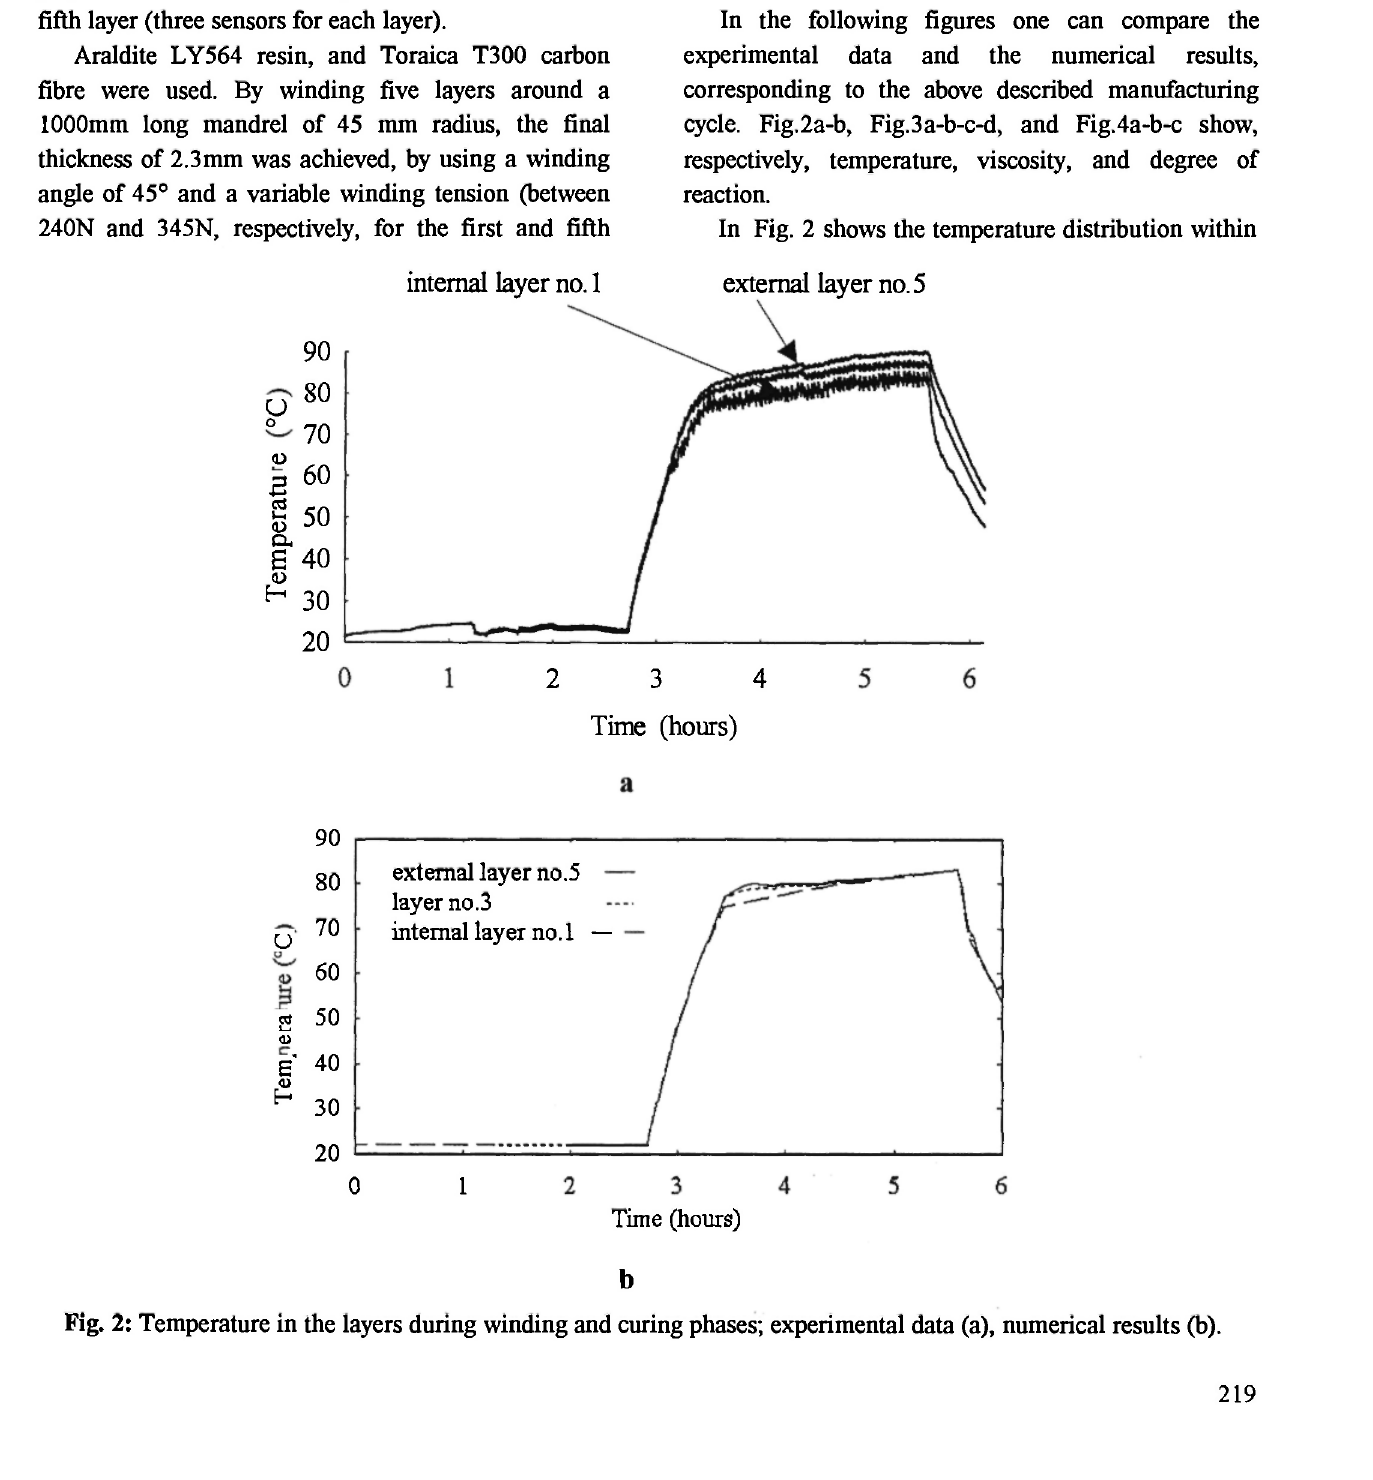
Fig. 2: Temperature in the layers during winding and curing phases; experimental data (a), numerical results